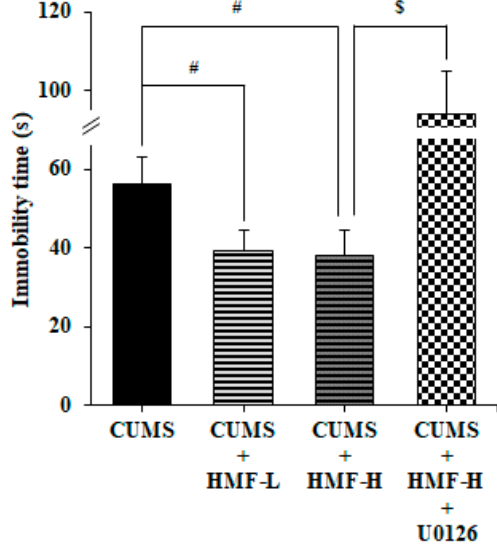
Figure 5. Effects of HMF on CUMS-induced depression-like behavior in the forced swim test on Day 16. Values are means ± SEM ( n = 15–16). Symbols show significant differences between the following groups: CUMS vs. CUMS + HMF-L, CUMS vs. CUMS + HMF-H ( # p < 0.05, one-way ANOVA followed by the post-hoc Williams multiple comparison test) and CUMS + HMF-H vs. CUMS + HMF-H + U0126 ( $ p < 0.05, the Student’s t -test).